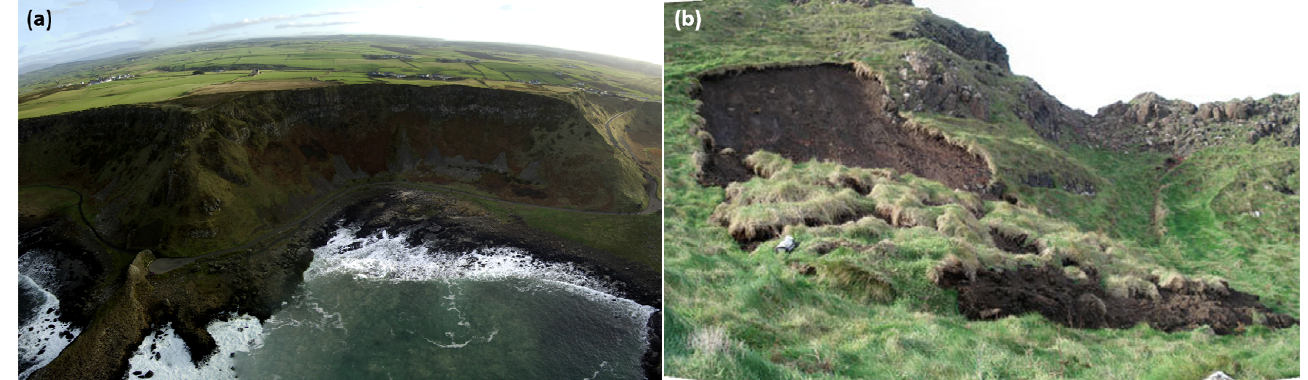
Figure 2. ( a ) Aerial photograph showing Port Ganny. ( b ) Translational slide at Port Ganny, which took place during summer 2008 (photo from Reference [21]).